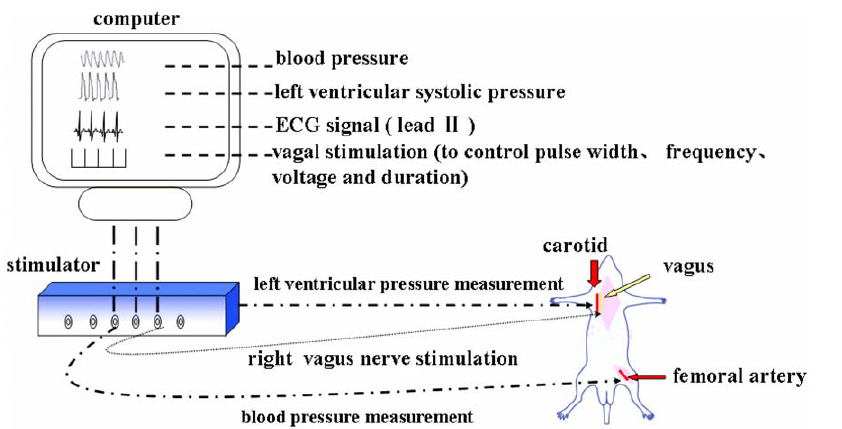
Figure 1. The schematic representation of the experimental set up. During the experiment, the distal end of right vagus nerve was stimulated. A polyethylene catheter (PE) catheter was inserted into the left femoral artery to monitor the blood pressure. Another PE catheter was inserted into the right carotid artery to measure the changes of left ventricular pressure. The intense of vagal stimulation was controlled by the computer which was connected with the simulator. The signal of vagal stimulation was output by the stimulator and was displayed in the computer.